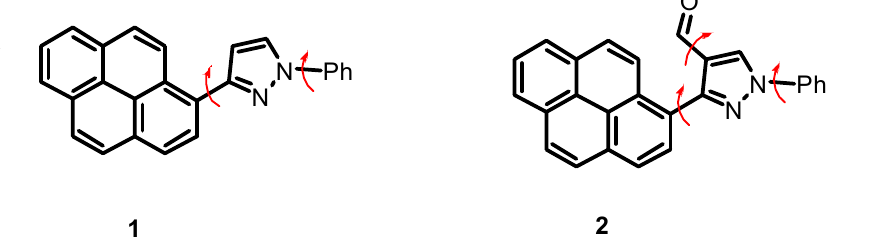
Figure 1. Molecular structures of pyrazolylpyrenes 1 and 2 . Arrows indicate possible rotations around single bonds.